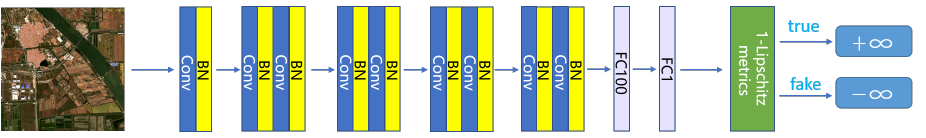
Figure 4. The architecture of the D. It is responsible for encouraging the G to generate images similar enough to real-world HR data. “BN” is batch normalization for short, “Conv” refers to convolutional layer, and “FC{ N }” represents a fully connected layers outputting N -element